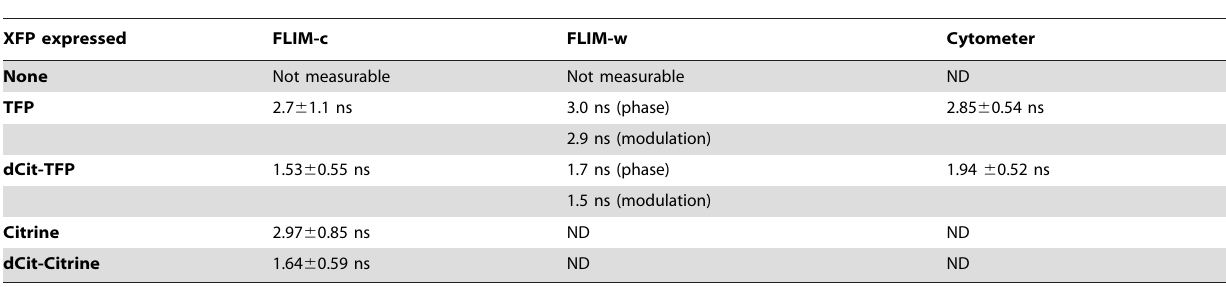
Table 2. Fluorescence lifetime by microscopy and flow cytometry.